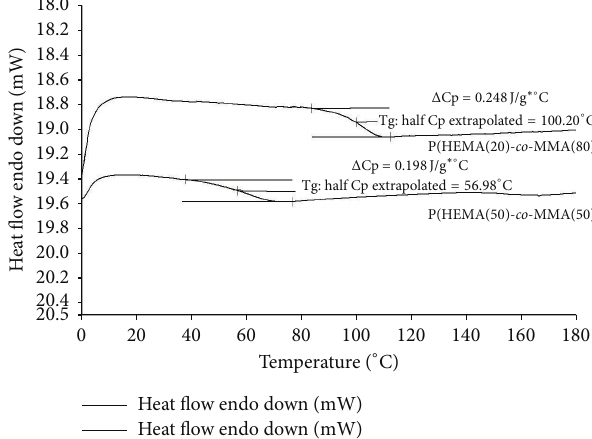
Figure 6: The DSC curves of P(HEMA(20)- co -MMA(80)) ( 1b ) and P(HEMA(50)- co -MMA(50)) ( 1d ) copolymers.